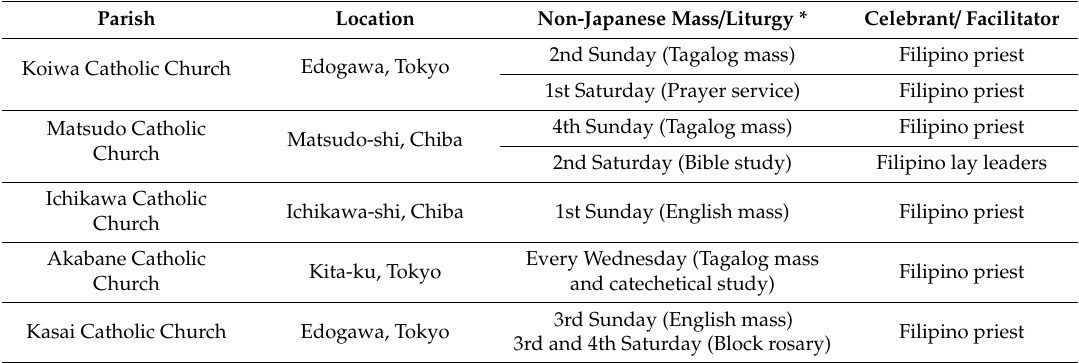
Table 1. The five (5) parishes that were determined as sample for 2016 field